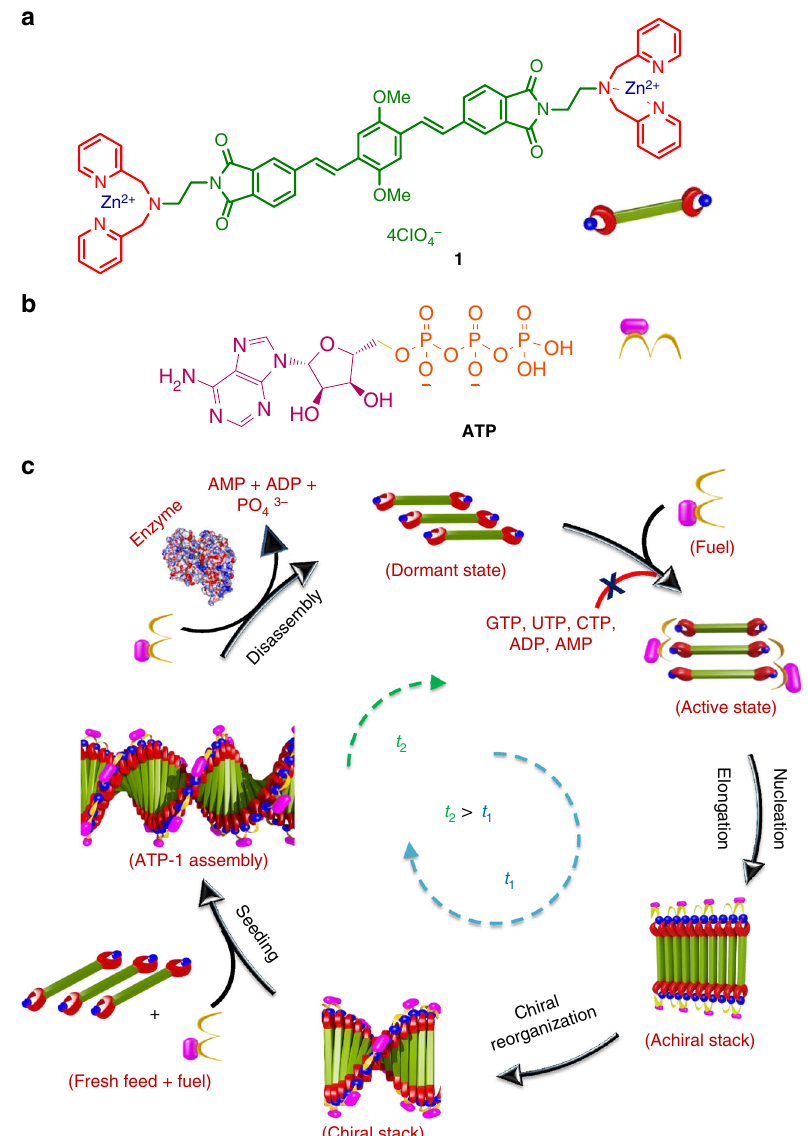
Fig. 1 ATP-driven temporal assembly of 1 . a , b Molecular structures of 1 and ATP, respectively. c Schematic representation of ATP-selective nucleation- growth and seeded assembly of 1 with enzymatically modulated transient characteristics. t 1 corresponds to the time required for the growth process and t 2 is the time required for disassembly on enzymatic hydrolysis of ATP where t 2 > t 1 , rendering a transient